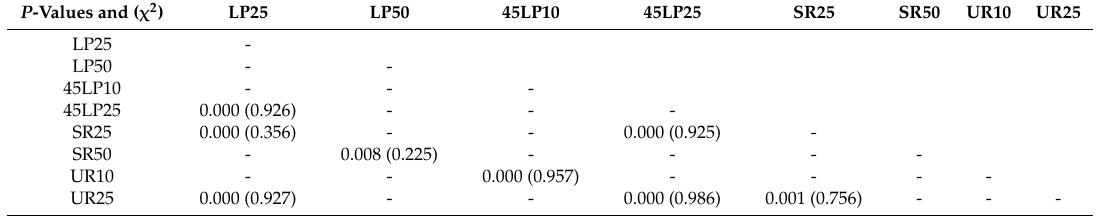
Table A6. P -values and ( χ 2 ) for normalized absolute values of transversal moments over all subjects—was not